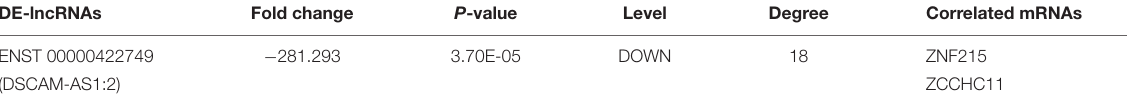
TABLE 1 | Correlated analysis between six candidate DE-lncRNAs and mRNAs. DE-lncRNAs Fold change P -value Level